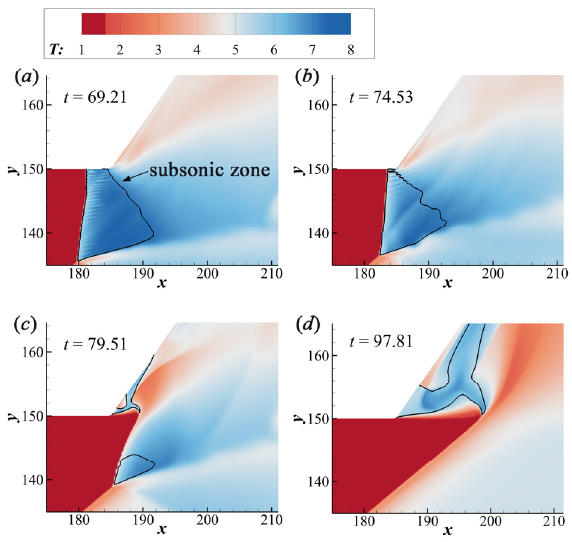
Figure 9. Local temperature fields (with the black line denoting sonic curves) of ODWs when M 0 increases at different instants. ( a ) t = 69.21, ( b ) t = 74.53, ( c ) t = 79.51, ( d ) t = 97.81.